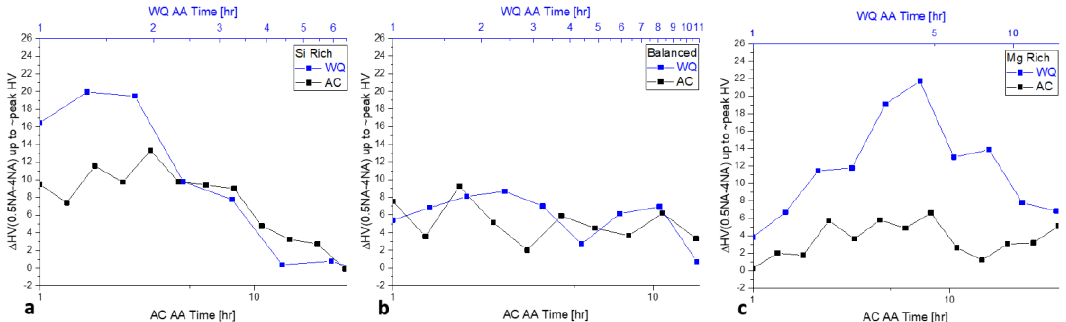
Figure 17. Difference in high strength alloy hardness due to prior NA (0.5 h NA–4 h NA) as a function of AA time, for both WQ and AC conditions. Positive values correspond to a ‘negative NA effect’. WQ and AC conditions are plotted on separate time axes, which are normalized to their respective peak AA times to allow for comparison. Error bars are omitted for clarity, but can be judged by the error in the individual measurements seen in Figures 3 and 6.